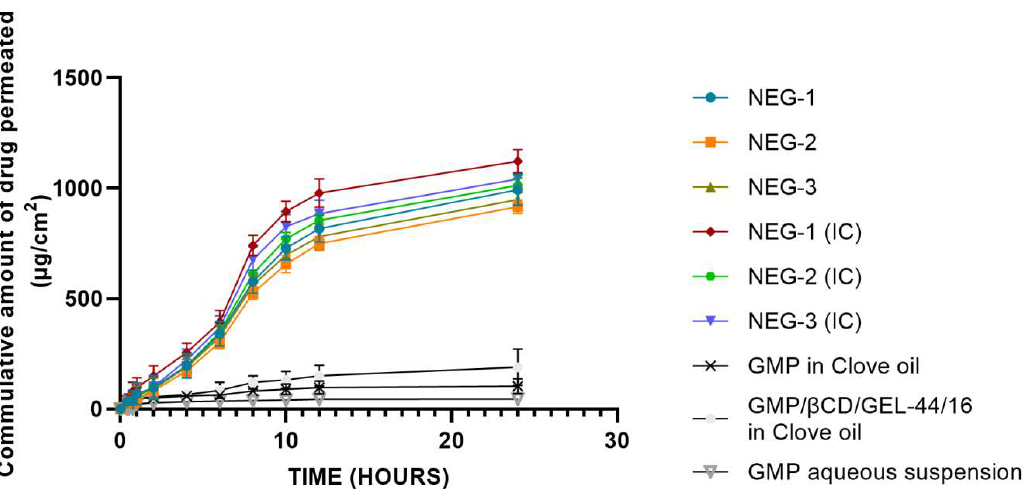
Figure 3. Permeation profile of GMP- and GMP/βCD/GEL-44/1-loaded nanoemulgels in contrast to their oily drug sus- pension.